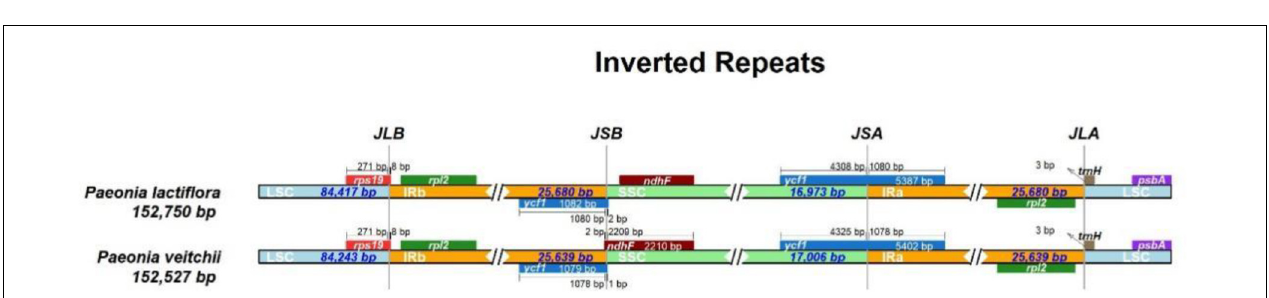
FIGURE 2 | Comparison of the LSC, IR, and SSC junction positions between Paeonia lactiflora and Paeonia veitchii.